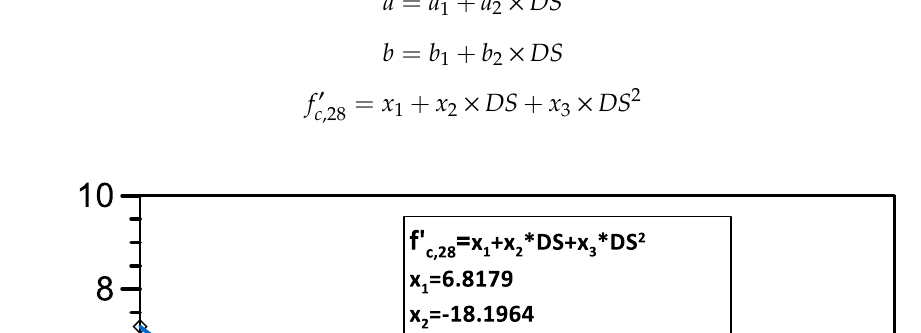
Figure 9. ( a ) The relationship between the hyperbolic function coefficient 𝑎 and the DS content. ( b ) The relationship between the hyperbolic function coefficient 𝑏 and the DS content.